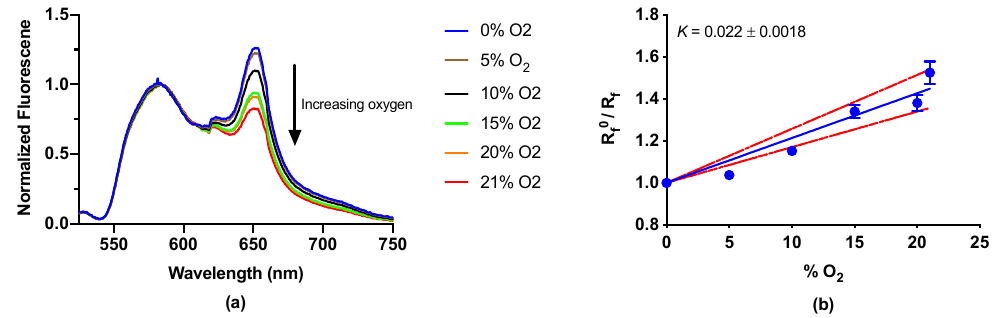
Figure 6. LipiSensors are effective at sensing oxygen. ( a ) Normalized spectrum of Lipisensors with varying oxygen concentrations (normalized to intensity at 585 nm, emission maximum of DiA). ( b ) Pseudo Stern–Volmer plot showing that oxygen quenches the luminescence of PtTFPP as expected ( n = 3). Red dashed lines depict a 95% confidence interval on the fit.